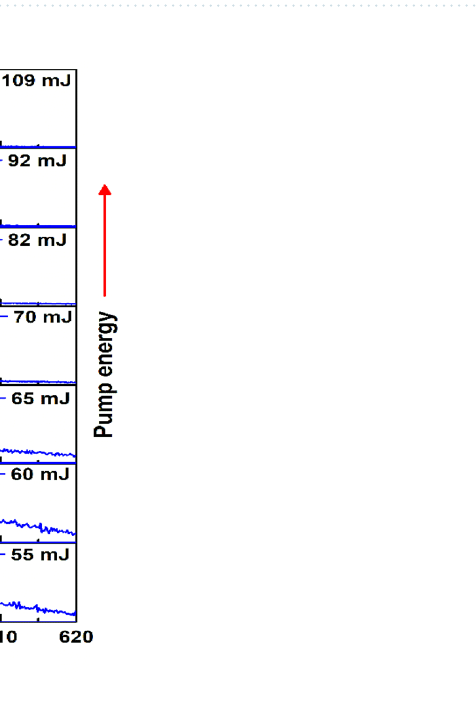
Figure 3. Evolution of the emission spectrum of Rhodamine 6G containing ZnO microspheres as a function of the pump